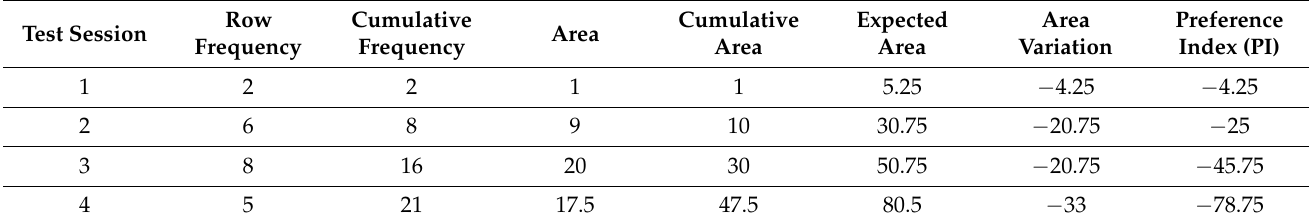
Table 1. Preference index steps. PI values of the fish one from social stress group going through the part of the device with tactile bristles before aggressive interaction during the 4 observations. Here, we are showing the fish 1, the same as Figure 5C, as an example. The PI indicates that fish did not prefer the tactile stimulation area. For details about calculations see Maia and Volpato